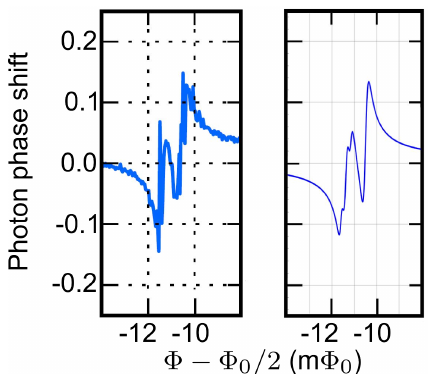
Figure 4. Experimental ( left panel ) and numerical ( right panel ) results for the photon phase shift ϕ (Φ) as a function of external flux bias Φ , calculated for the system of N = 7